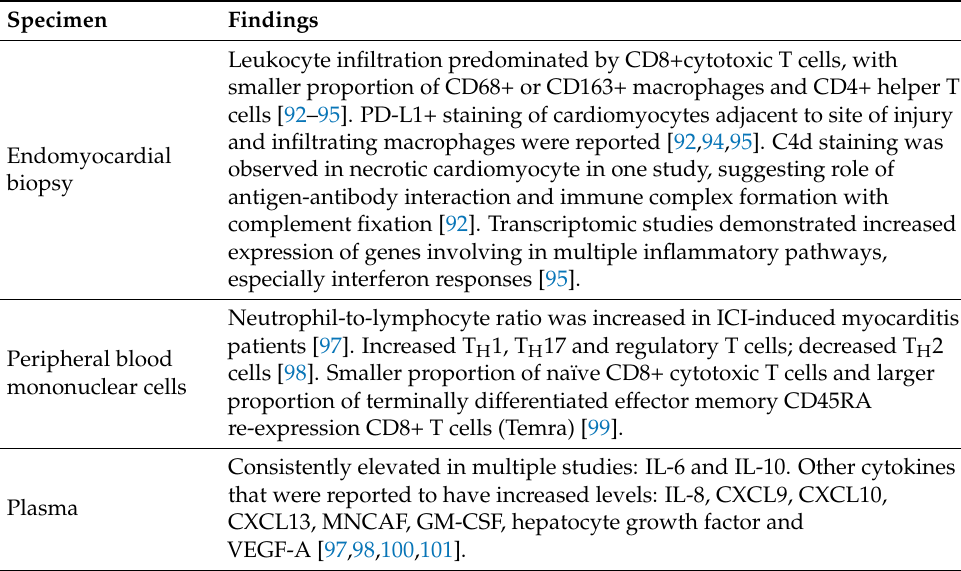
Table 2. Human Studies of Immune Checkpoint Inhibitor-induced